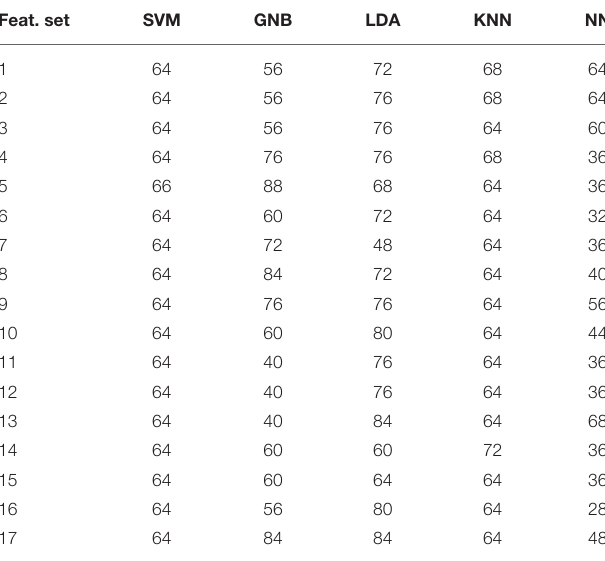
TABLE 4 | Performance of different models at different extracted features for unvoiced (U) modality obtained from SP channel. Feat. set